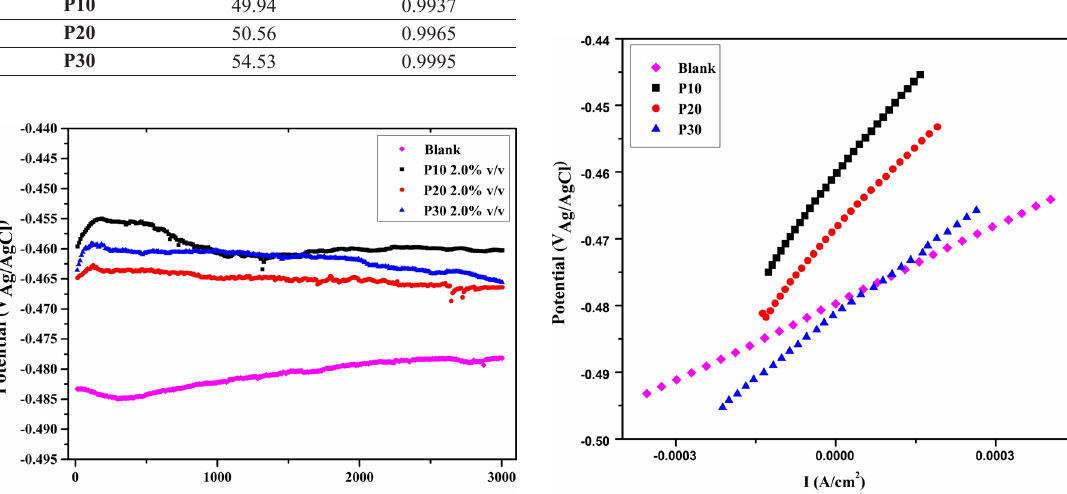
Figure 8. OCP for API P110 carbon steel coupons in the absence and presence of P10, P20 and P30 (2.0% v/v) at 298 K.